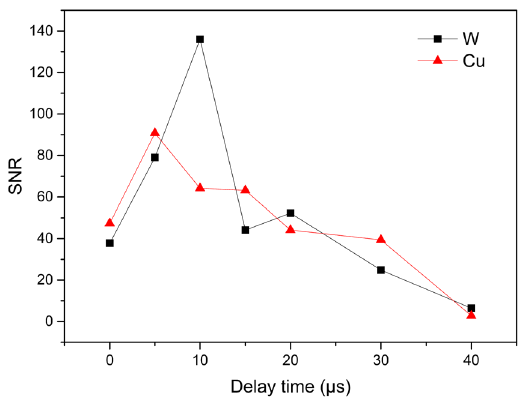
Figure 3. Variation of SNR of Si 288.16 nm with different delay